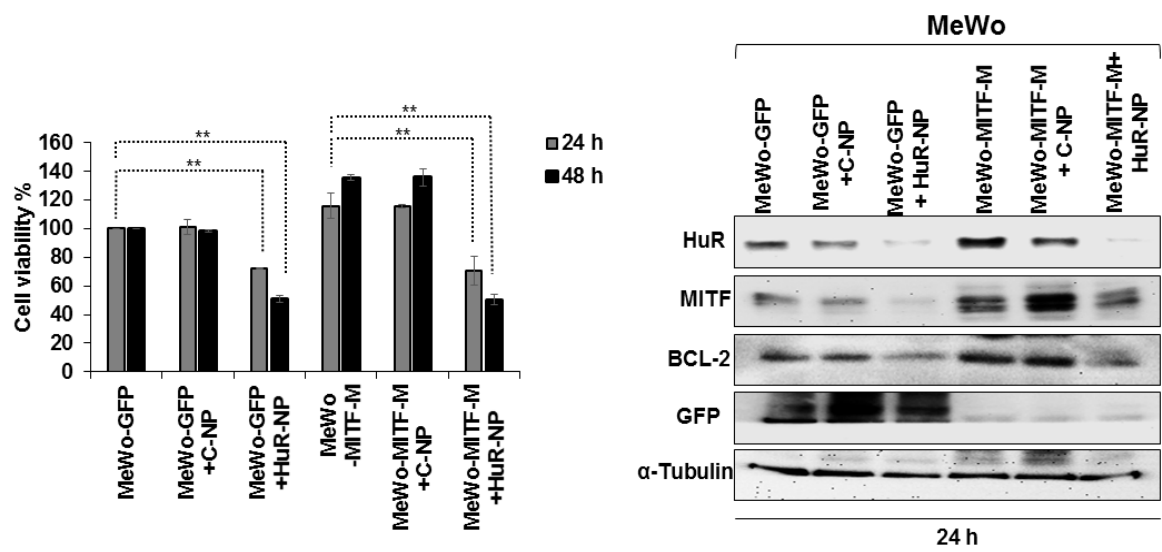
Figure 8. Cytotoxic effect of C-NP and HuR-NP treatment on MeWo-GFP and MeWo-MITF-M treated cells. HuR-NP significantly reduced the viability of both MeWo-GFP and MeWo-MITF-M cells at 24 h and 48 h compared to all other treatment groups. Western blotting showed HuR-NP reduced MITF, p-MEK1/2 Ser 217/221 and total MEK1/2, and BCL-2 protein expression in both MeWo-GFP and MeWo-MITF-M cells. α -Tubulin was used as an internal loading control. Error bar denotes SD; ** p < 0.01.